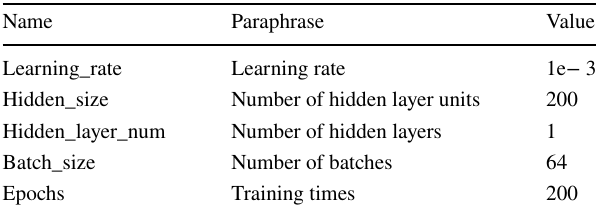
Table 7 The parameters of DKT